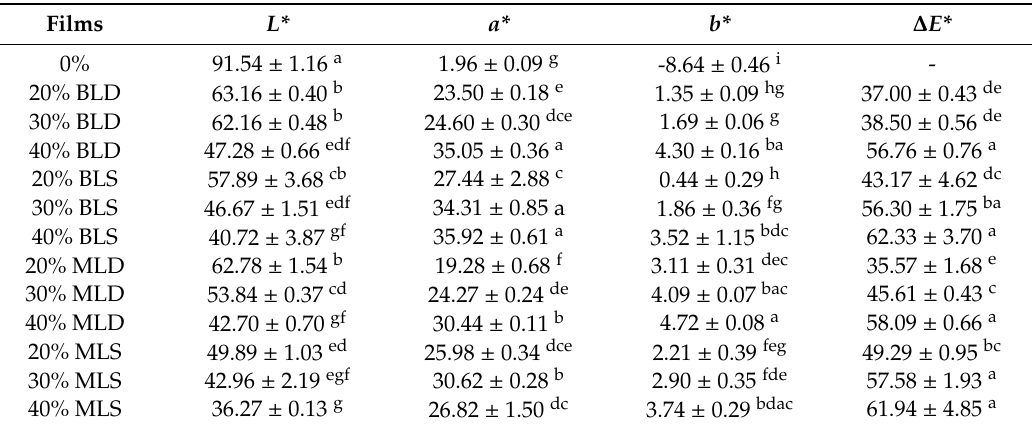
Table 2. Colour parameters of film samples with 0%, 20%, 30% and 40% of freeze-dried blackberry pulp (BL) and freeze-dried microencapsulated blackberry pulp (ML) incorporated directly (D) and by sprinkling (S). Results of the control film characterization (0%) were published by Nogueira, Fakhouri and Oliveira